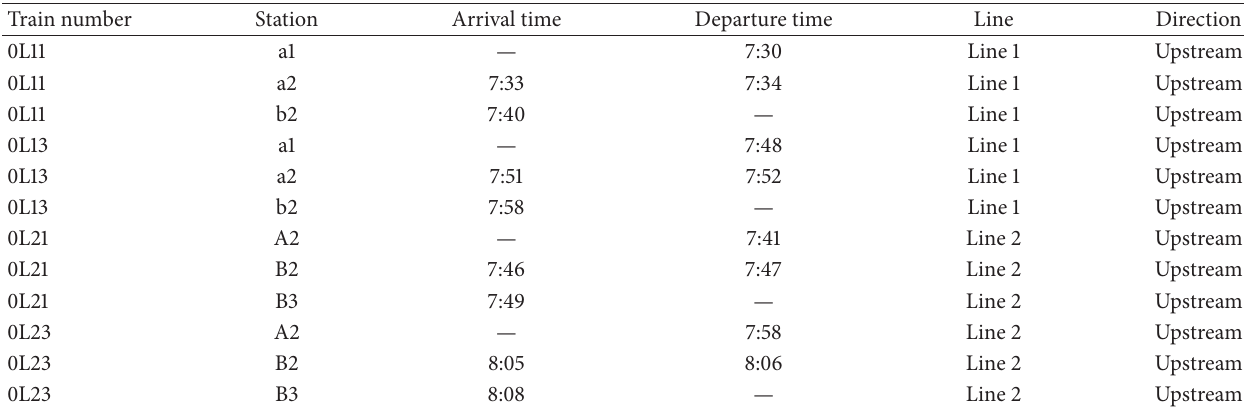
Table 1: Partial schedule of the small